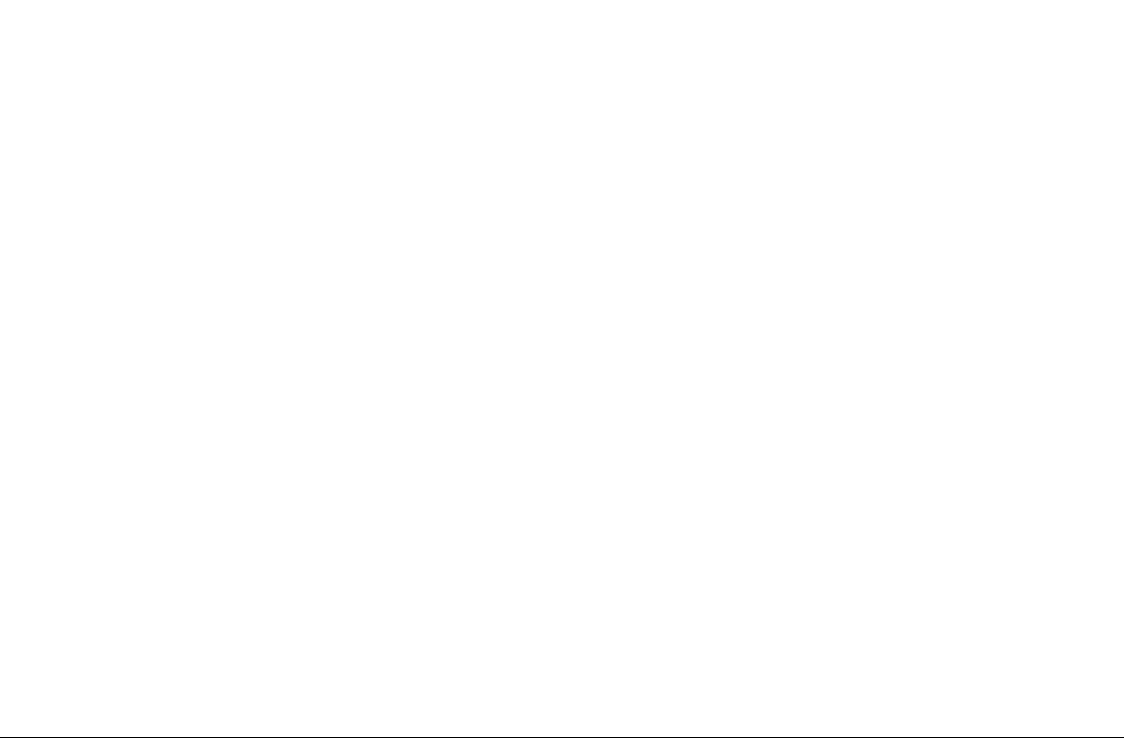
Silhouette information and the Pearson’s matrix correlation is depicted for 3 compartments each represented by 3 markers.The closer the value is to 1 the better the observed cluster validity, color-coded as depicted in the right-side bar.To aid visualization negative cluster validity values were set to 0 and contour lines were drawn for each 0.05